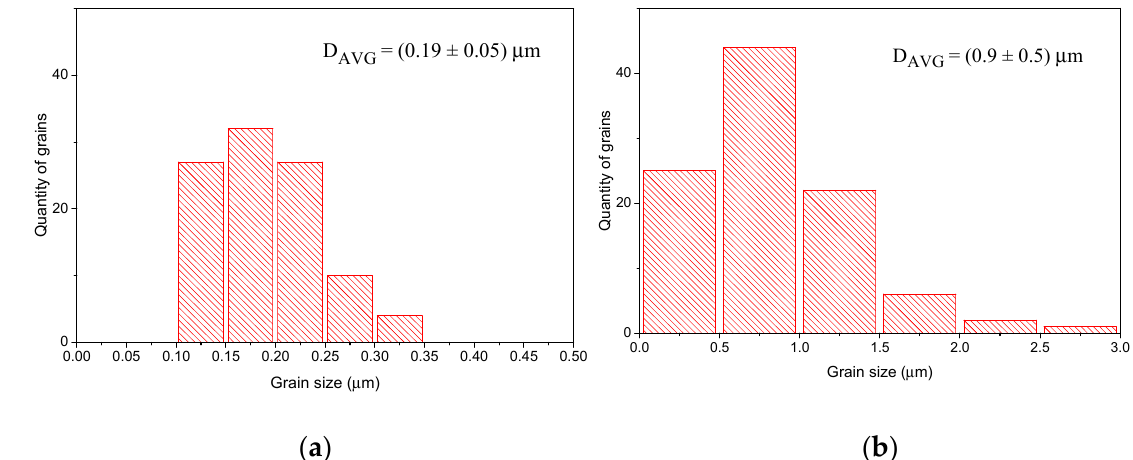
Figure 10. Grain size distribution of grains ( a ) below and ( b ) above 0.5 μ m size for BLCF milled with 5 mm diameter balls.